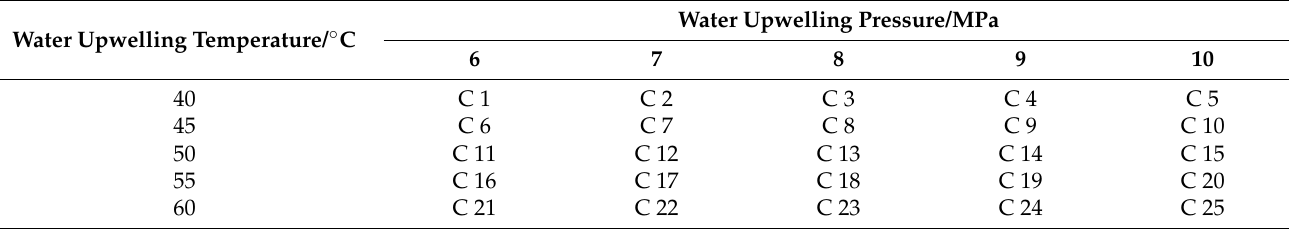
Table 5. Different water upwelling temperature and pressure